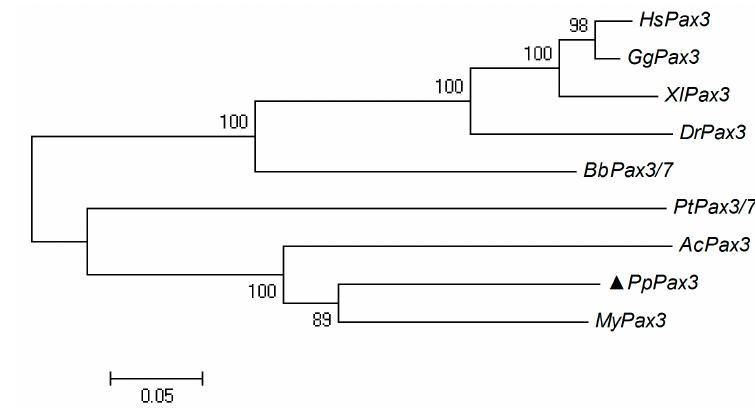
Figure 2. Sequence alignment and phylogenetic analysis. ( A ) Multiple sequence comparison of Pax3 among different species including Pteria penguin ( Röding , 1798 ) ( PpPax3 , MH558581), Mizuhopecten ( DrPax3 , AAC41253.1), Homo sapiens ( HsPax3 , NP_852122.1), Xenopus laevis ( XlPax3 , AAI08574.1) and Gallus gallus ( GgPax3 , BAB85652.1). The conserved amino acids were written in black background, and similar amino acids were shaded in green and pink. PD, octapeptide motif and HD were indicated in blue boxes. ( B ) Phylogenetic tree of Pax3 genes. Numbers in the branches represented the bootstrap values (as a percentage). ▲ meaned the Pax3 of P. penguin.